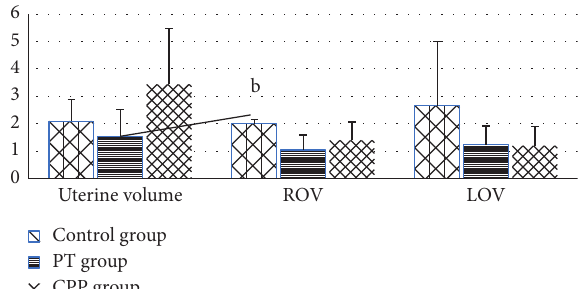
Figure 2: Comparison of the uterine volume and ovarian volume among the three groups. “A” represents comparison among the three groups, P < 0 . 05; “B” represents comparison between PTand controls, P < 0 . 05; “C” represents comparison between CPP and controls; “D” represents comparison between CPP and PT, P < 0 . 05.